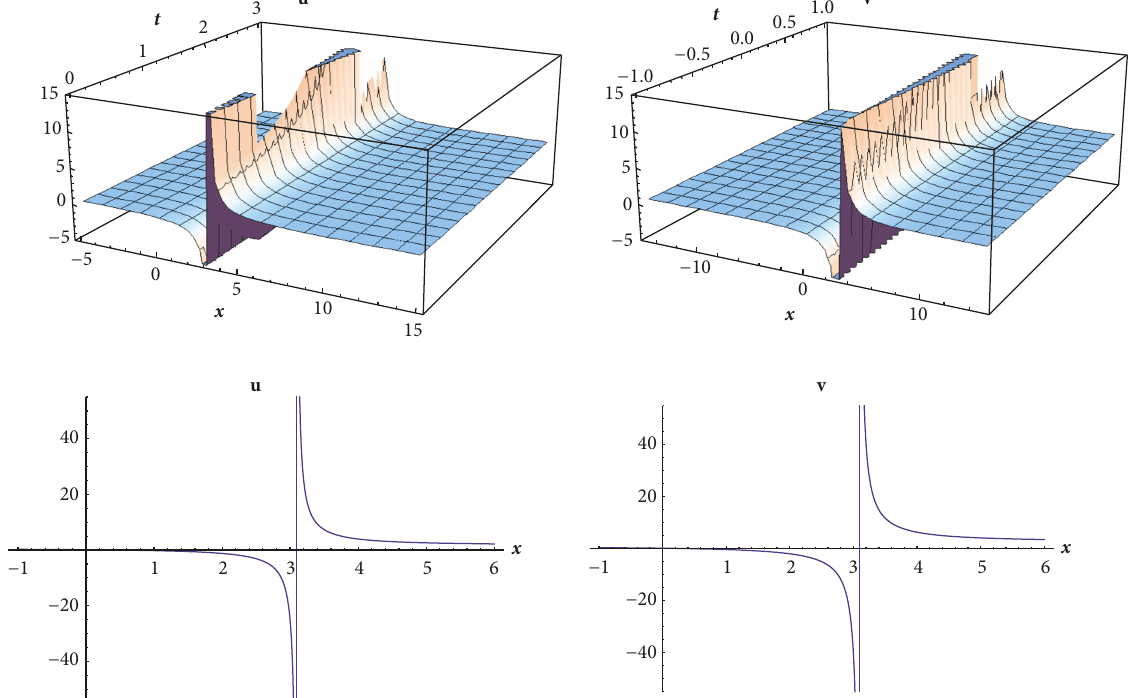
Figure 3: The 3D and 2D surfaces of the solution (24) by considering the values 𝑏 1 = 0.5 , 𝑎 1 = 0.2 , 𝑘 = 1.6 , 𝑐 = 0.2 , 𝑑 = 0.01 , ∝= 0.8 , 𝜎 = 0.3 , 𝜖 = 0.9 , 𝑦 = 1.5 , and 𝑡 = 0.007 for 2𝐷